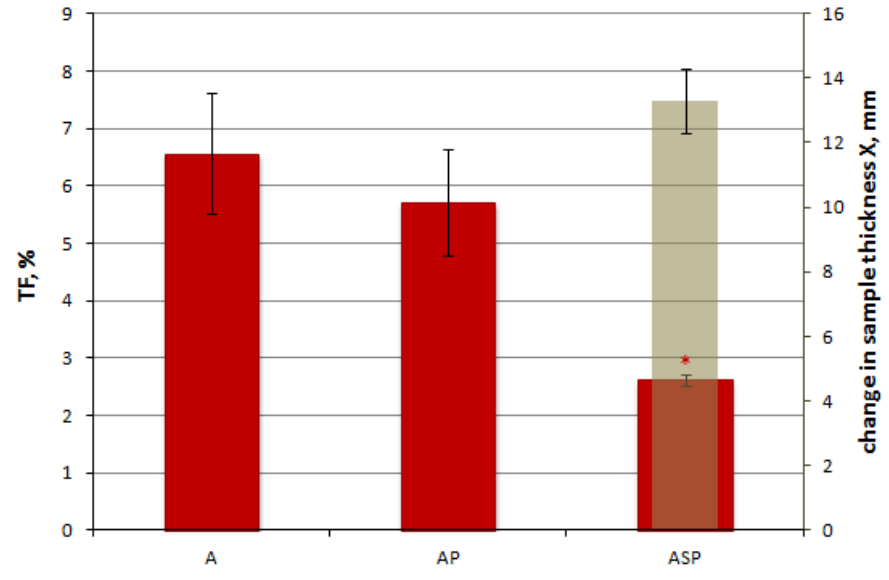
Figure 8. Test results of the heat transmission factor (TF).